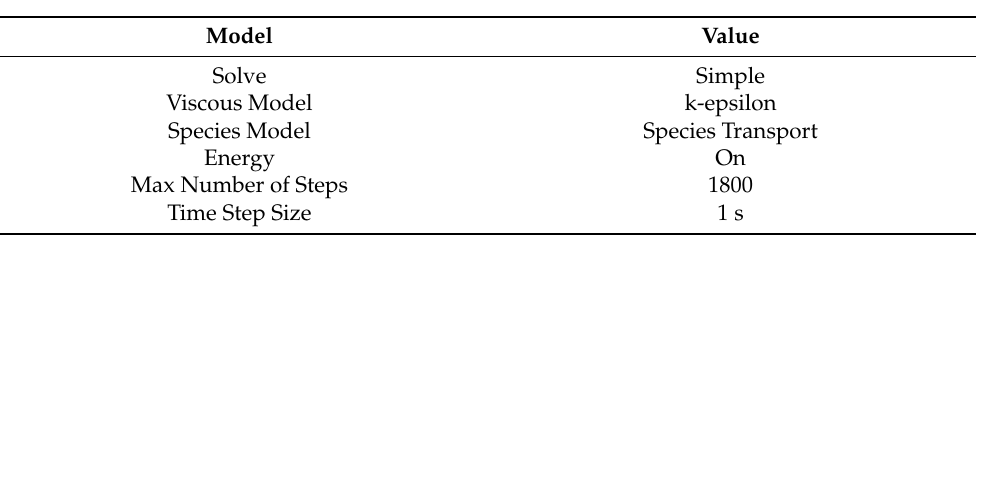
Table 2. Settings of model parameters for Test